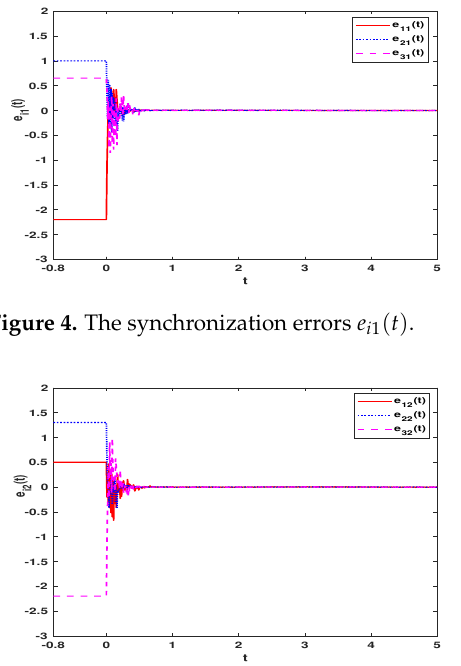
Figure 5. The synchronization errors e i 2 ( t )